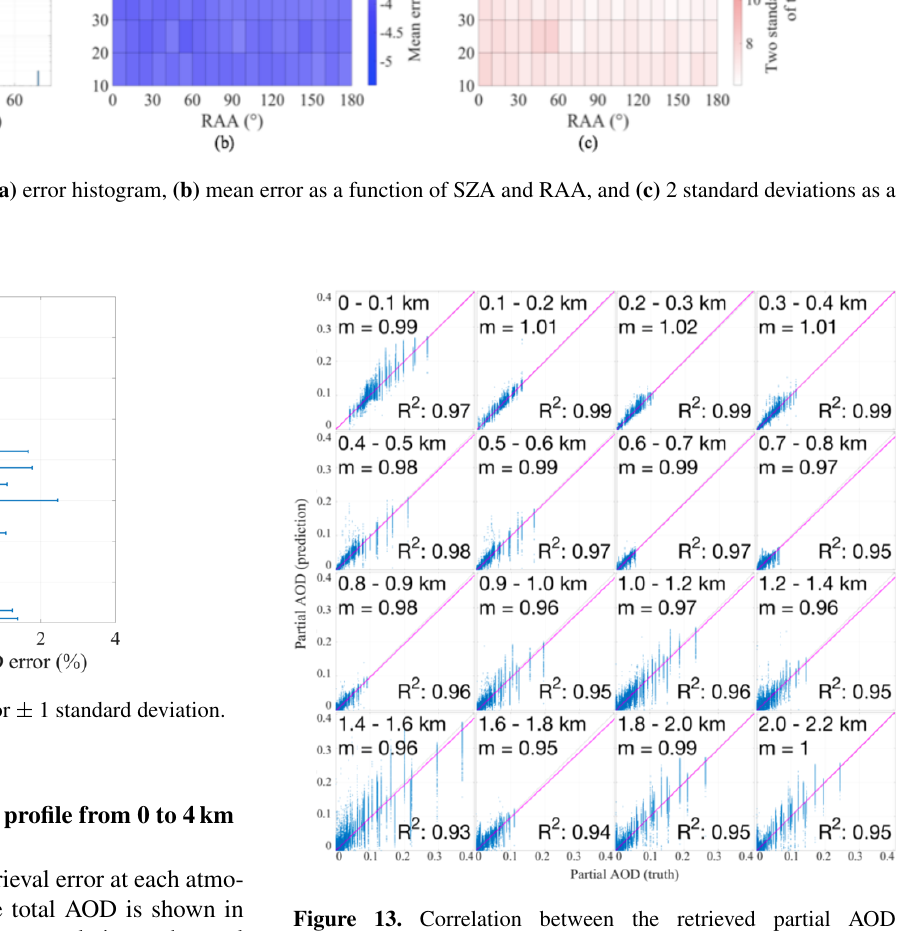
Figure 13. Correlation between the retrieved partial AOD and the true partial AOD for each layer from 0 to 2.2km (retrieved partial AOD = m · true partial AOD + intercept). The in- tercept of all linear regression analyses is 0 with RMS < 0 .